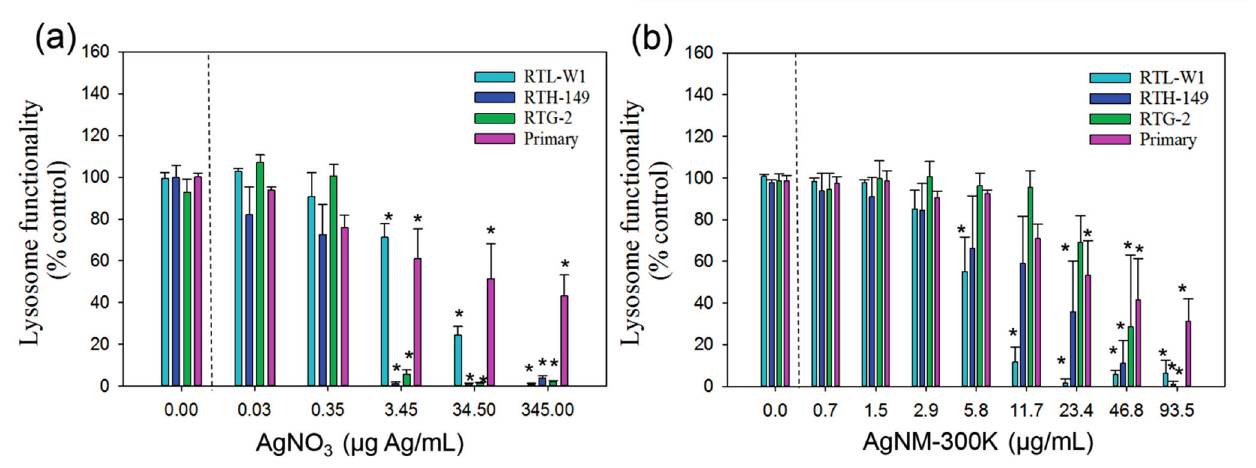
Figure 3. Cytotoxicity of AgNO 3 and AgNPs NM-300K according to NRU assay; ( a ) Cytotoxicity measured using the NRU assay and lysosome functionality as toxicity endpoint in liver cell lines (RTL-W1 and RTH-149), a gonadal cell line (RTG-2) and primary hepatocytes from rainbow trout following 24 h exposure to AgNO3; ( b ) silver nanomaterial NM-300K. Cells exposed to concentration 0 received the maximal concentration of the dispersant and served as control. Values represent the mean ± standard error of the mean (SEM) (n = 3); * denotes statistically significant differences from control ( p <